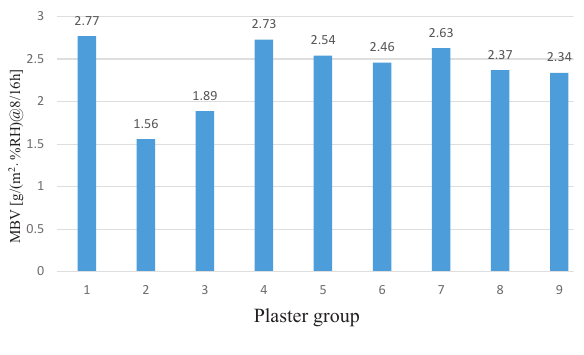
Fig. 4. MBV of plaster groups.